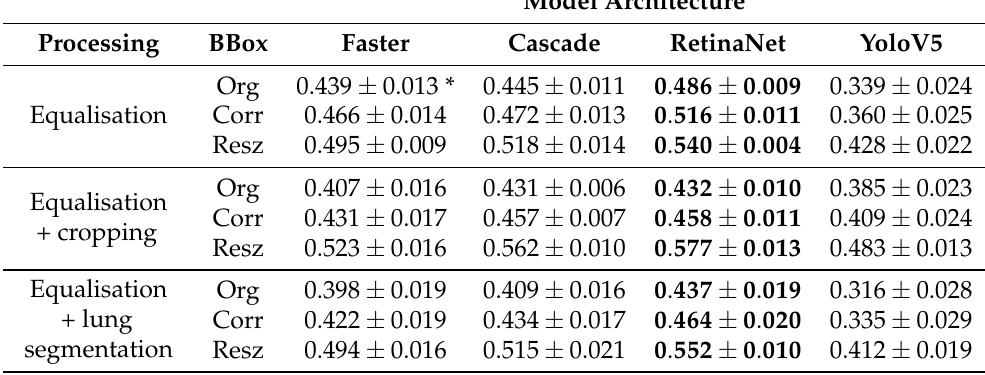
Table 5. Performance of the different model architectures for different image pre-processing strategies, evaluation procedures, and a semi-supervised approach. The BBox column has the same meaning as in Table